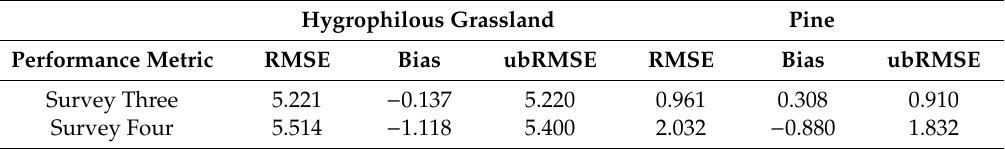
Table 4. Survey performance metrics.